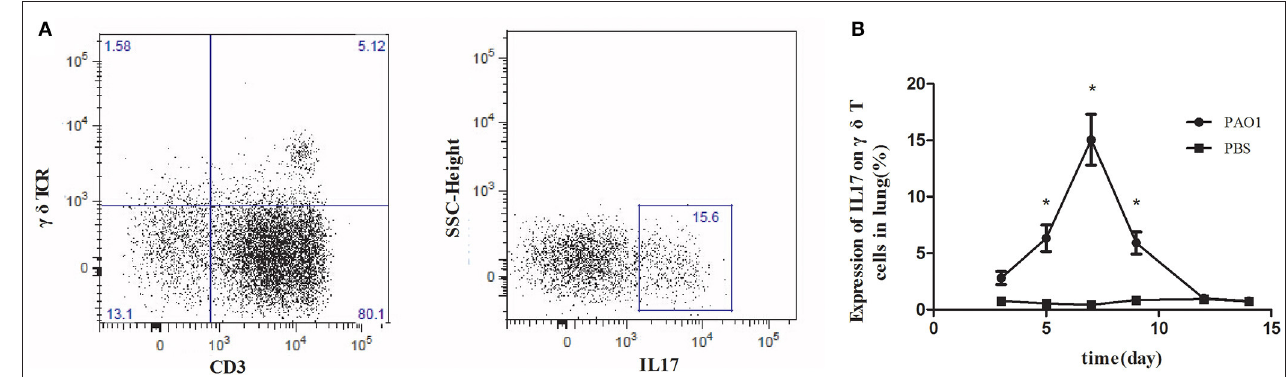
FIGURE 1 | Increased IL-17 expression on γδ T cells in the lungs in response to Pseudomonas aeruginosa infection. C57BL/6 mice were inoculated with 20 µ l PAO1 (1 × 10 8 CFU ml − 1 ) or PBS ( n = 5). At 3, 5, 7, 9, 12, and 14 days following infection, lung mononuclear leukocytes were harvested from the lung, pooled and stimulated with ionomycin and phorbol 12-myristate 13-acetate for 6 h. Lung mononuclear cells were stained with antibodies recognizing CD3, γδ T-cell receptor ( γδ TCR), and intracellular IL-17. The cells were first gated on CD3 and γδ TCR (left, A ) and then the CD3 + γδ TCR + cells were gated on IL-17 (right, A ). The expression of IL1-7 on γδ T cells was measured (B) . * p -value < 0.05. These results represent three independent experiments.